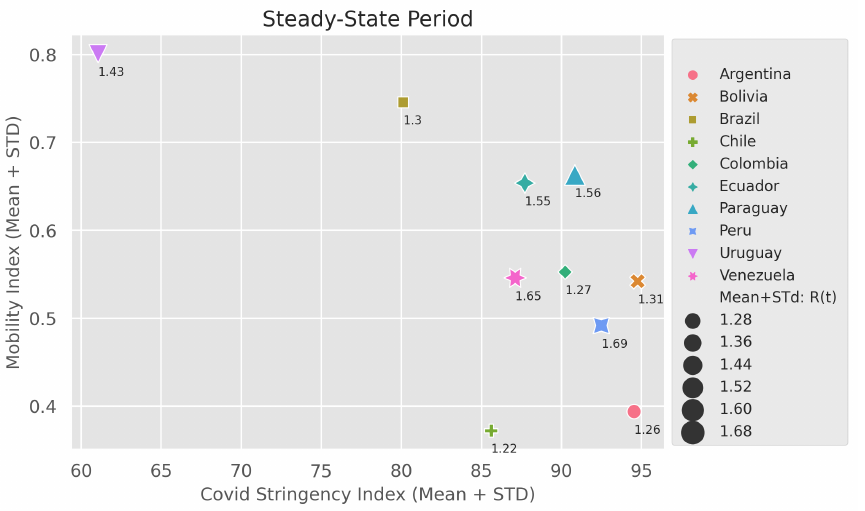
Figure 9. Community mobility index, Covid stringency index, and R ( t ) : Steady-state period. Source of basic data: Covid-19 Community Mobility Reports, Oxford Covid-19 Government Response Tracker (OxCGRT), and Covid-19 Community Centre for Systems Science and Engineering (CSSE) at Johns Hopkins University